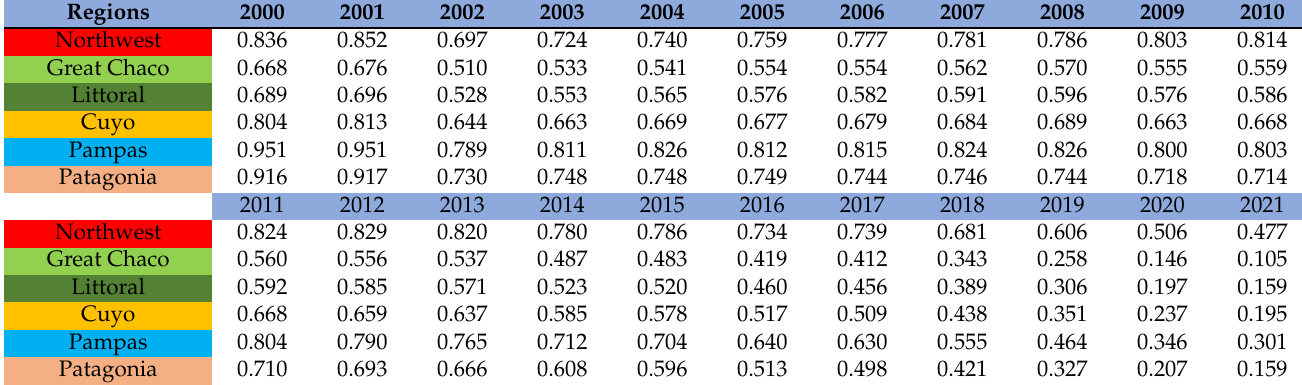
Table 12. Estimated income index—Argentina